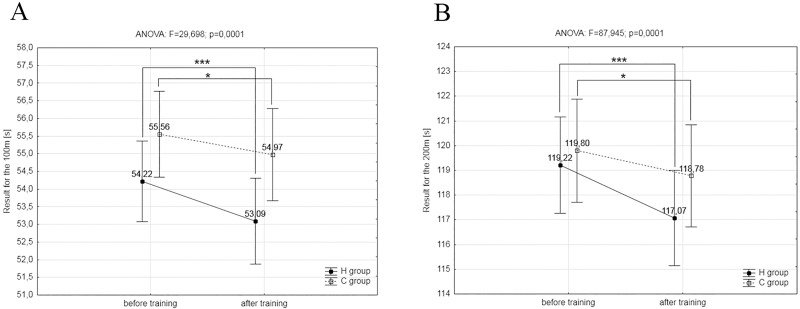
A, B. The results of the swimming tests.(A) The results of the 100m swimming tests in the experimental (H, n = 8) and control groups (C, n = 7) before and after the experiment. (B) The results of the 200m swimming tests in the H and C groups before and after the experiment; *-p<0.05, *** p<0.001—significant differences in relation to initial measurements.